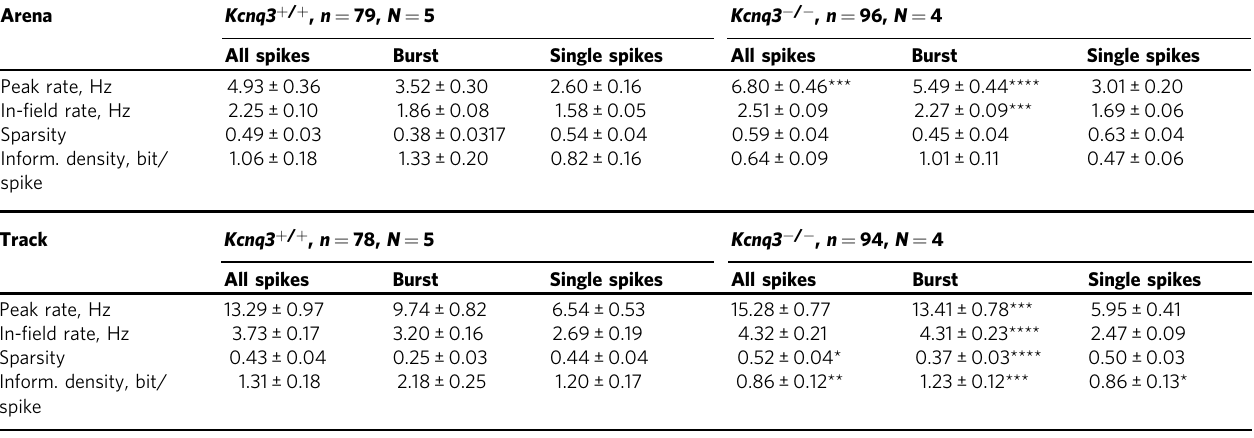
Table 2 Properties of place cells.